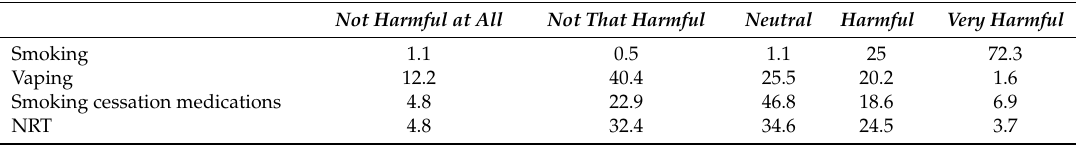
Table 4. Distributions of responses (in %) of perceived harmfulness (on a scale from not harmful at all to very harmful ) for smoking, vaping, smoking cessation medications, and nicotine replacement therapy (NRT).